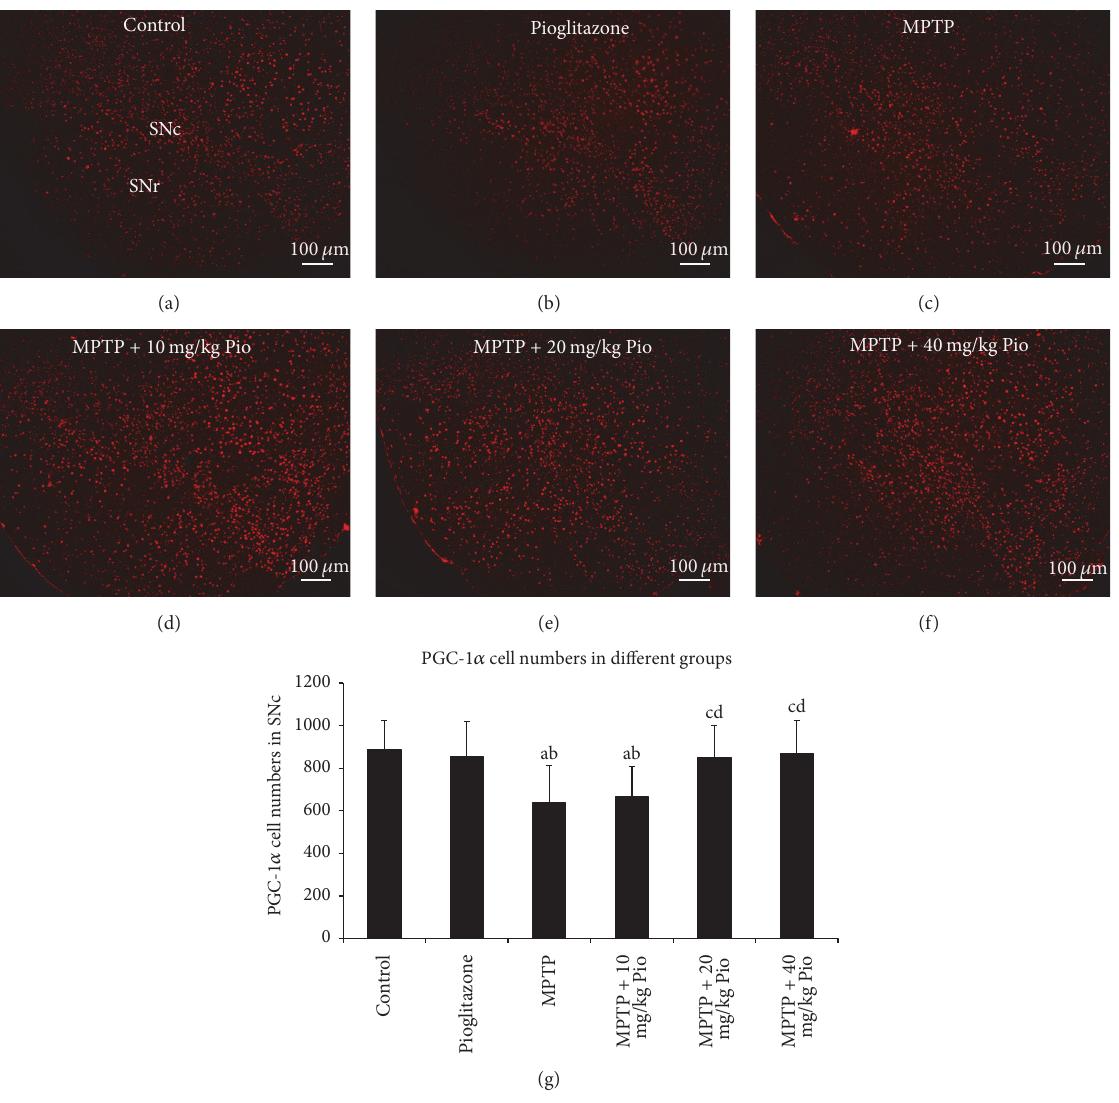
Figure 3: Effect of pioglitazone on PGC-1 𝛼 expression in MPTP C57BL/6 mice. “a” indicates 𝑃 < 0.05 , compared with control group; “b” indicates 𝑃 < 0.05 , compared with pioglitazone group; “c” indicates 𝑃 < 0.05 , compared with MPTP group; “d” indicates 𝑃 < 0.05 , compared with MPTP + 10mg/kg Pio group. The bars in (a)–(f) indicate 100 𝜇